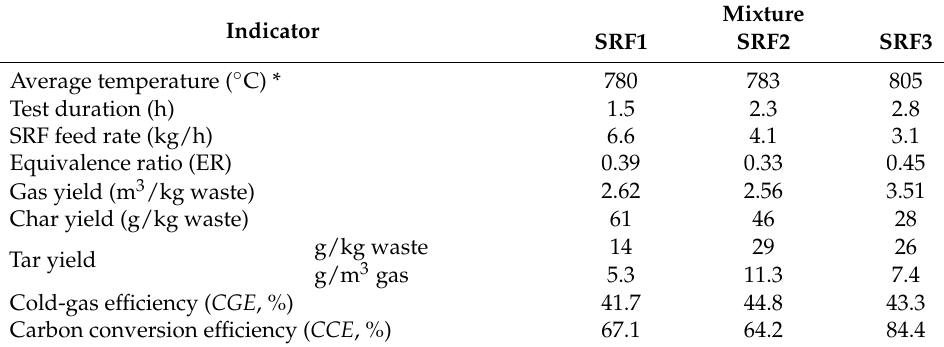
Table 5. Performance indicators of gasification